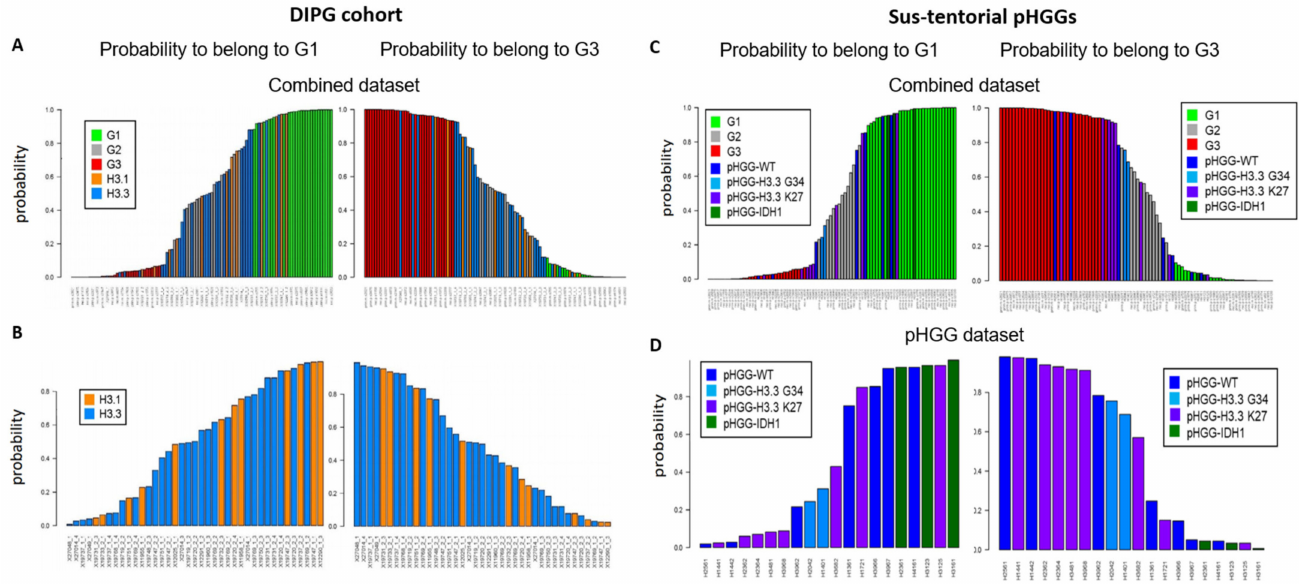
Figure 2. Group prediction in larger cohorts of pHGG using adult DD repair and cell cycle signature. Prediction of the G1, G2, and G3 status of the indicated specimens from a cohort of DIPG ( A , B ) or sus-tentorial pHGGs ( C , D ). Predictions were obtained by random forest analysis using the Köln cohort of aGBMs as training dataset, as in Figure